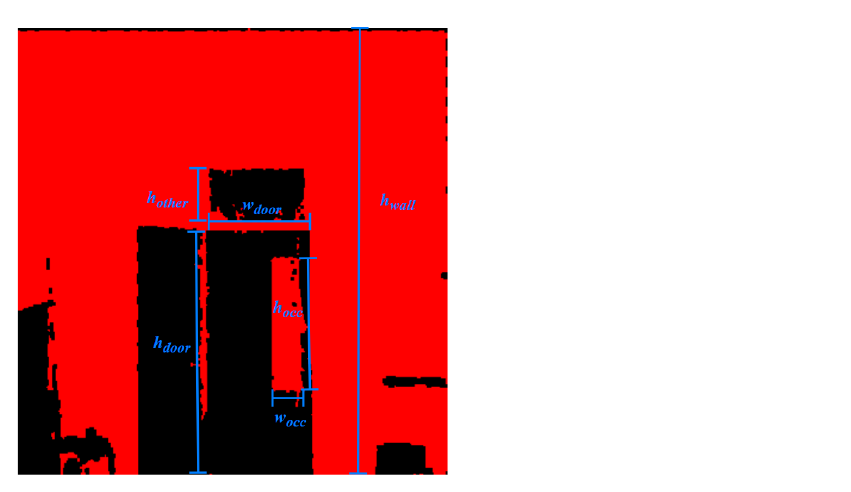
Table 1. Summary of parameters for model extraction and reconstruction.